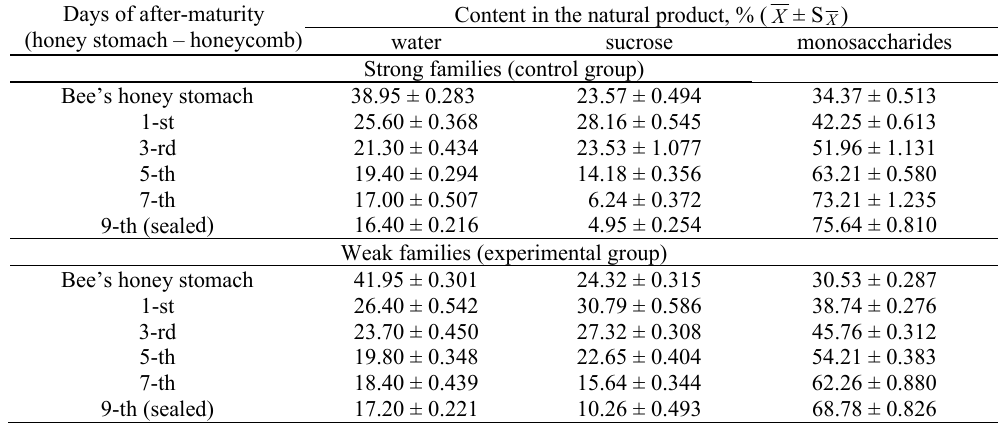
Dynamics of dehydration and inversion of sucrose by bees of strong and weak families, n = 3 Days of after-maturity (honey stomach –